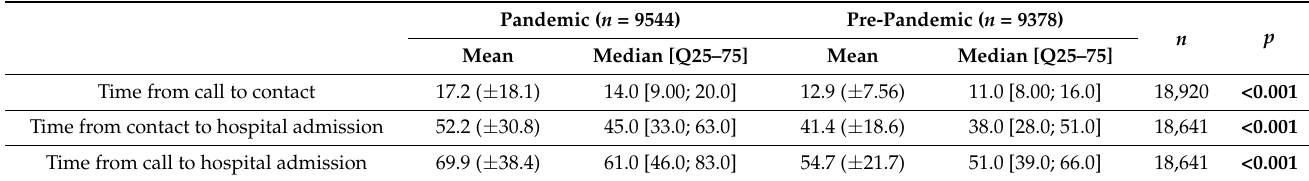
Table 7. Prehospital time